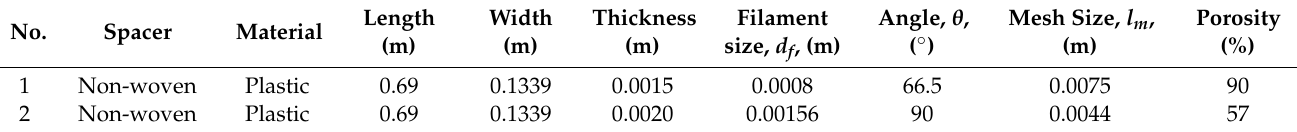
Table 2. Characteristics of spacers.